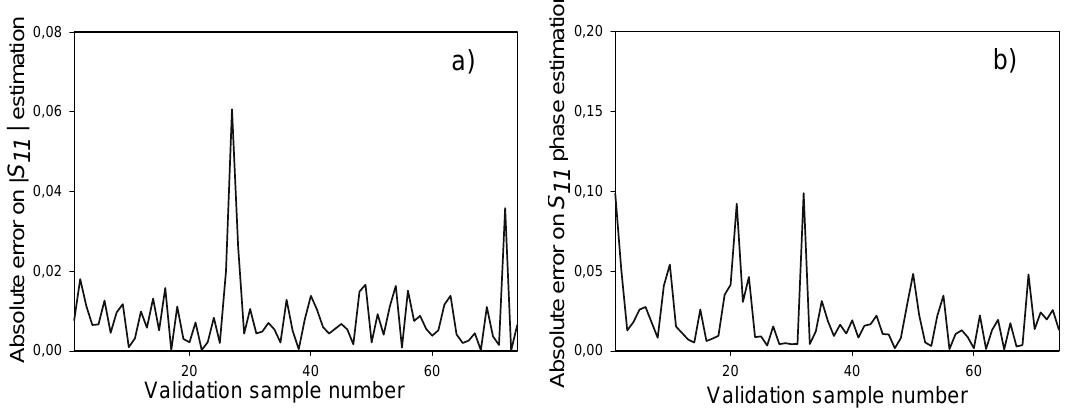
magnitude. (b) S phase. 11 11